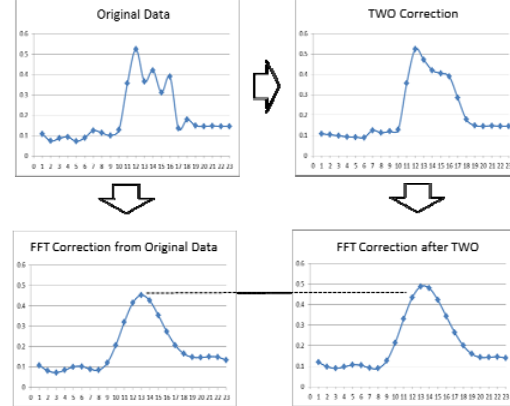
Figure 3. Application of noise reduction using TWO and FFT to time-series NDVI